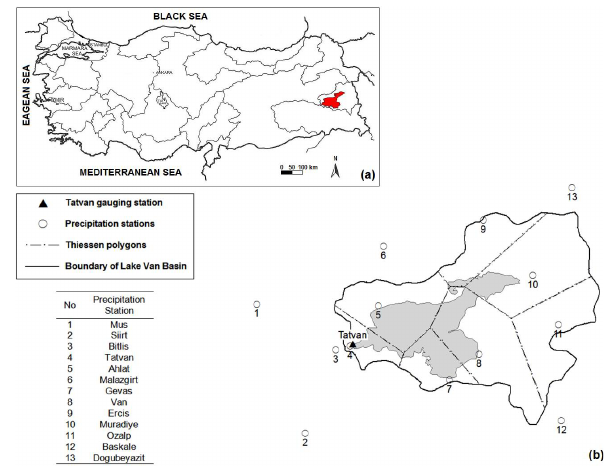
Fig. 1. (a) Location of Lake Van in Turkey, (b) Lake water level gauging station in Tatvan and precipitation stations surrounding the